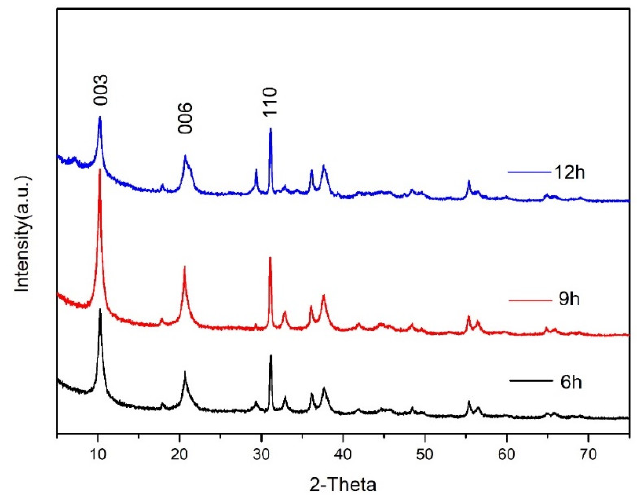
Figure 6. XRD patterns of CaAl–SiO 3 –LDHs prepared at different crystallisation time.